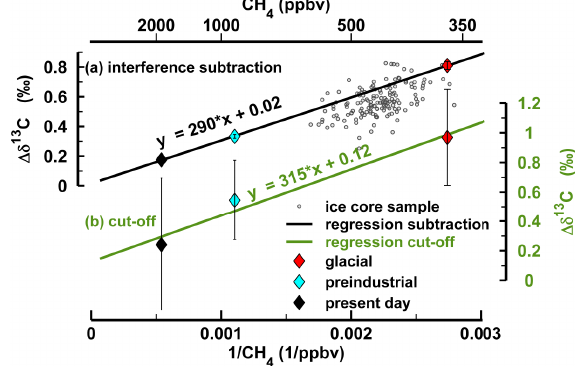
Fig. 12. Comparison of two methods to account for the Kr interference based on measurements with the AWI system using the three intercomparison cylinders with contrasting CH 4 /Kr mixing ratios. Plotted are the 13 C numbers, i.e., the differences between the original results and the results obtained after removing the Kr effect. Both methods reveal that with decreasing CH 4 concentrations (hence, CH 4 /Kr mixing ratios) 13 C becomes larger. (a) Results for the method of Sect. 5.4, where the Kr interference is subtracted from the raw data time series. Coloured diamonds with error bars mark the cylinder measurements, grey circles show a data set of 152 ice core measurements (b) Results for the relatively simple method, where the right integration boundary is shifted from 10 s to 3 s after the CH 4 peak maximum to cut-off a large fraction of the Kr peak. This method is more vulnerable to peak shape variations leading to more noise in the results.